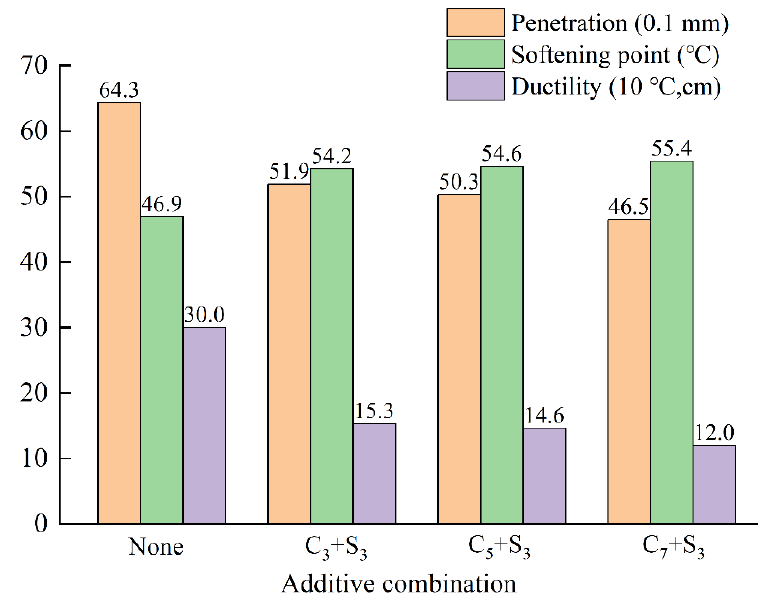
Figure 12. The changing law of the three major indexes of asphalt with the content of activated carbon.